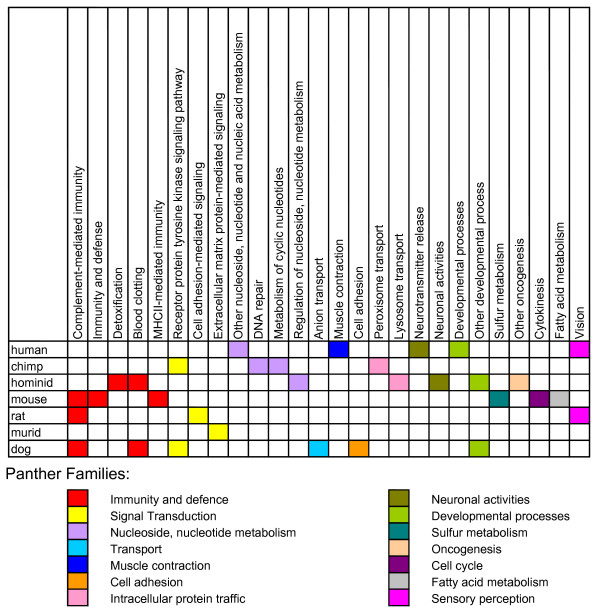
Biological Process ontologies over-represented by PSGs. Biological Process ontology terms which had an over-representation of PSGs (p < 0.05). Ontology terms are grouped by functional protein PANTHER Biological Process families.